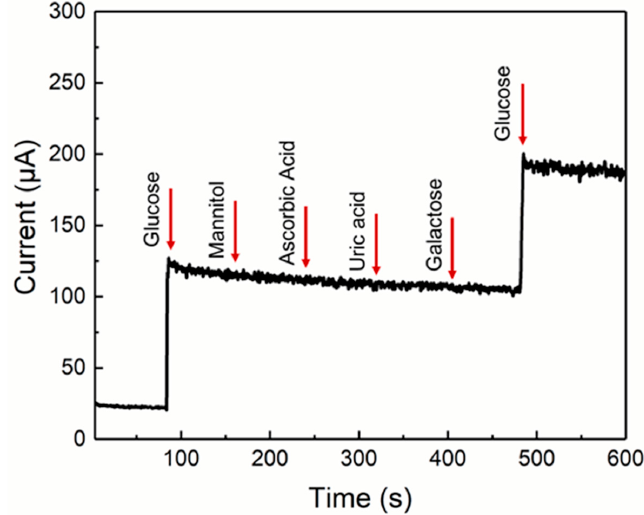
Figure 5. Non-enzymatic amperometric responses for the detection of glucose and interfering substances.